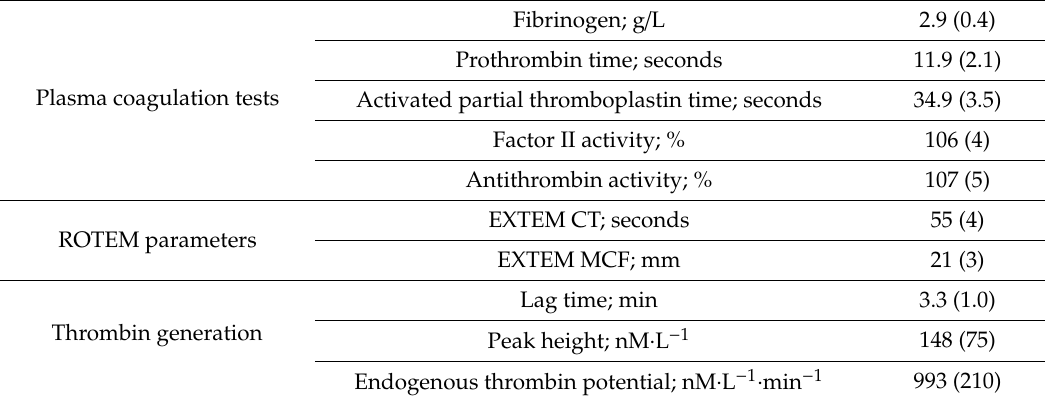
Table 1. Baseline values of plasma coagulation tests, thromboelastometry (ROTEM) parameters, and thrombin generation measurements obtained from platelet-free plasma. Values are mean